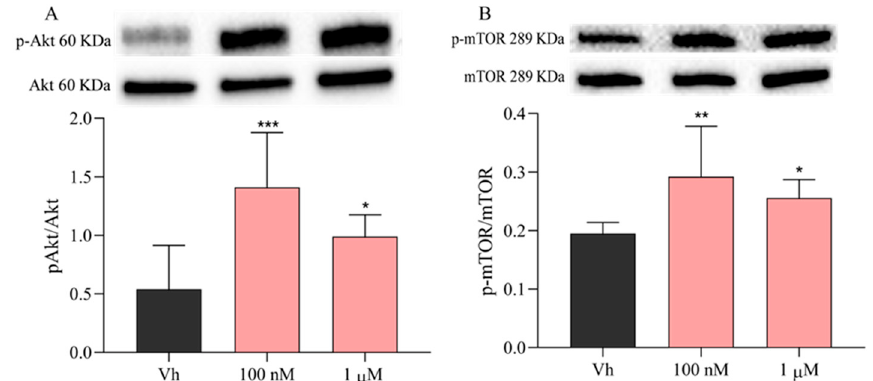
Figure 6. Phoshporilation of Akt and mTOR in differentiated SH-SY5Y cells after the treatment with VNZ. Cells were differentiated with retinoic acid and then treated for 48 h with VNZ 100 nM or 1 µ M. The phosphorilation of Akt ( A ) and mTOR ( B ) was evaluated by Western Blotting. Data are expressed as the ratio between the phosphorylated form and the total protein expression and reported as mean ± SD of three independent experiments (( A ): * p < 0.05 and *** p < 0.001 vs. VH; ( B ): * p < 0.05 and ** p < 0.01 vs. VH. One-way ANOVA, post hoc test